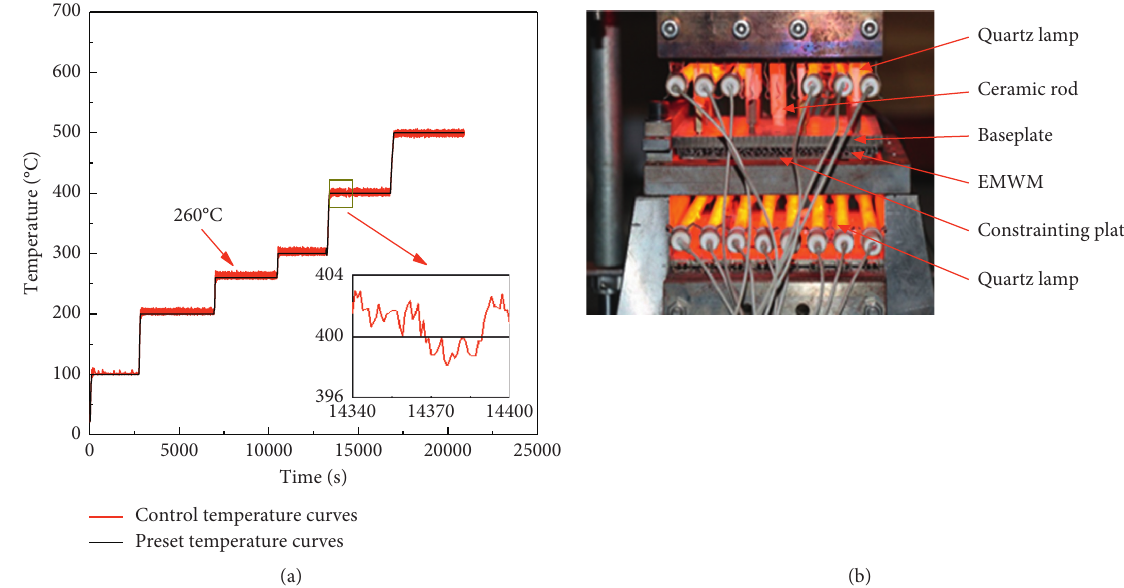
Figure 14: Thermal-vibration joint test. (a) Preset and control temperature on the cantilever structure. (b) Experiment picture.